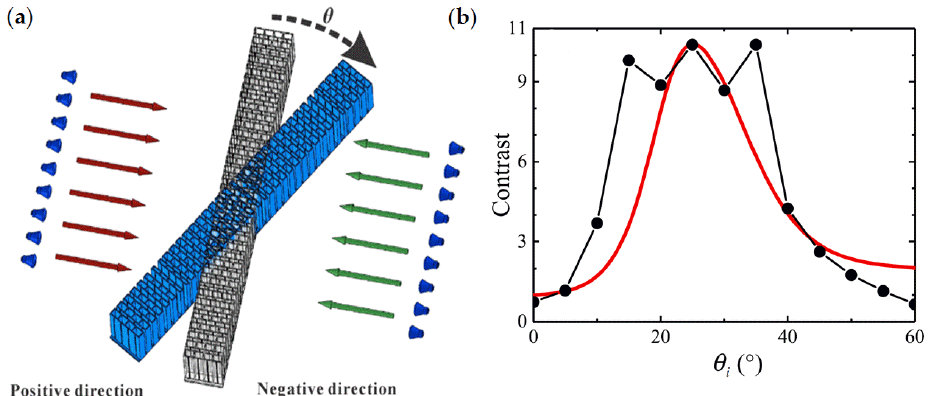
Figure 13. ( a ) The experiment setup of the fabricated prototype. The left (right) incidence corresponds to the positive (negative) direction case; ( b ) Energy contrast with different angles of incidence at 3430 Hz (red curve, simulation; black circles, measurement). Adapted with permission from [153], APS, 2017.